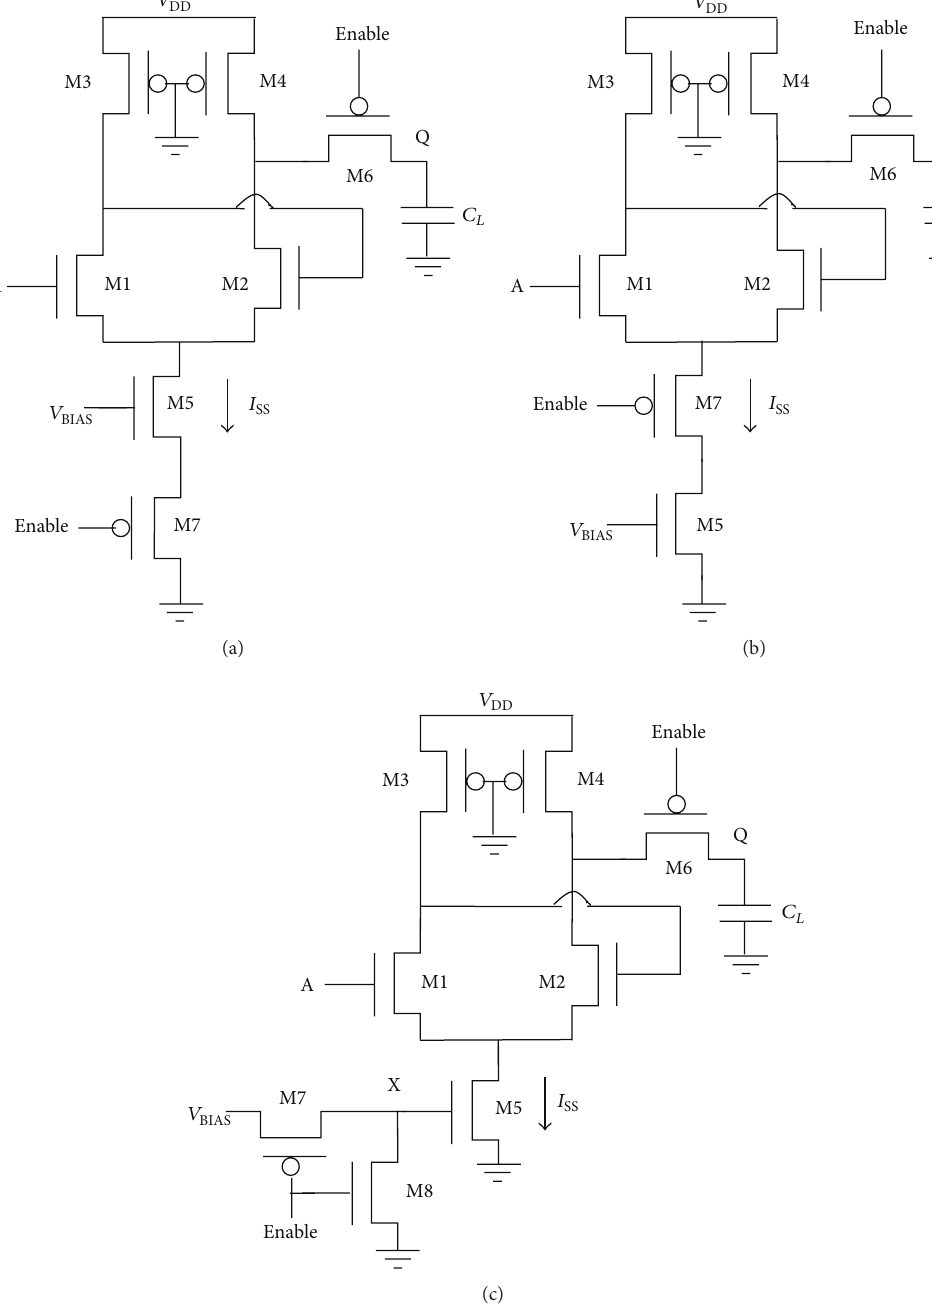
Figure 5: Proposed PFSCL tristate buffer: (a) topology 2, (b) topology 3, and (c) topology